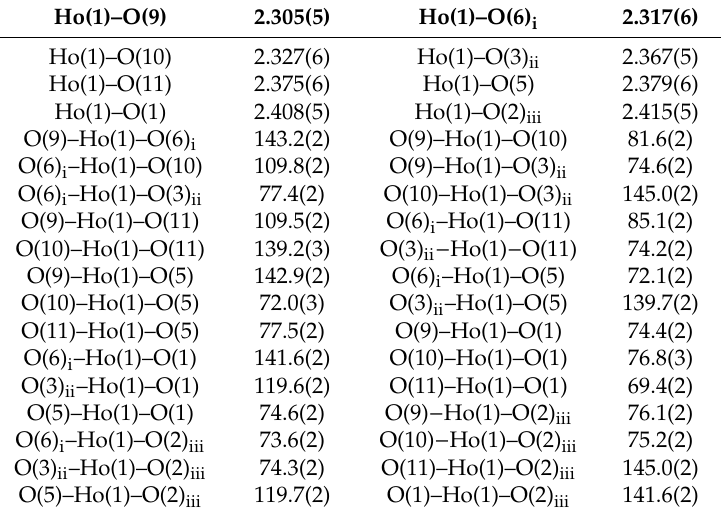
Table 4. Bond lengths (Å) and angles ( ◦ ) around Ho(III) ion in 2 1 .